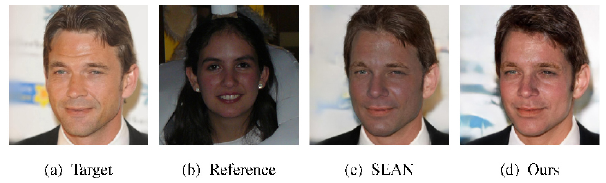
Fig. 1 An example of skin transfer. The R-ST&M method can modify the transferred skin to match the global lighting of the target image. However, without considering the relationships between different regions, the synthesised region in (c) is not in harmony with other regions.